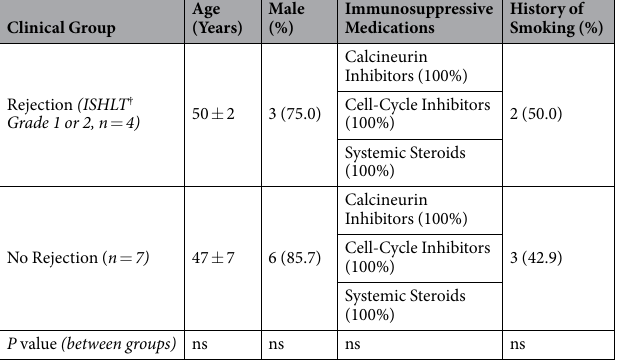
Table 1. Patient Demographics * . * Data expressed as mean ± SD or n (%). † ISHLT = International Society for Heart and Lung